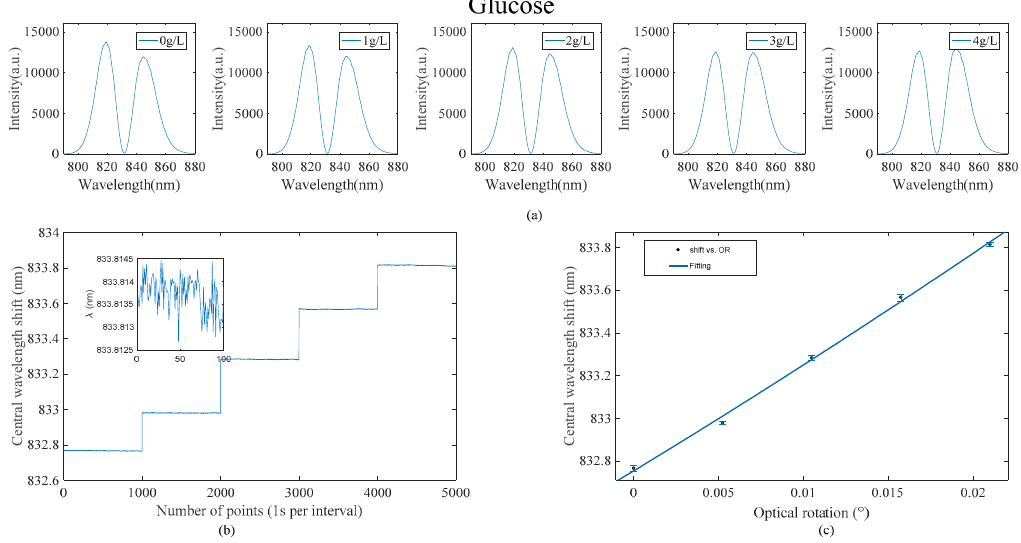
Figure 3. ( a – c ) The bimodal, central wavelength, and linear fit figures for different concentrations of glucose solution, respectively.